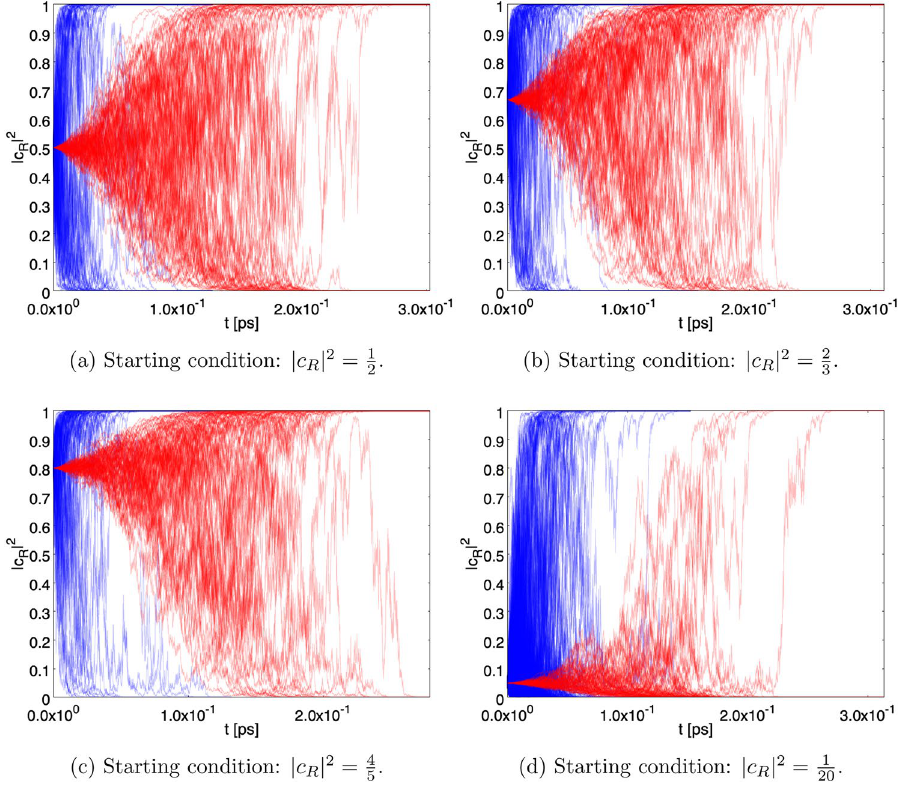
2 ) as function c R | |